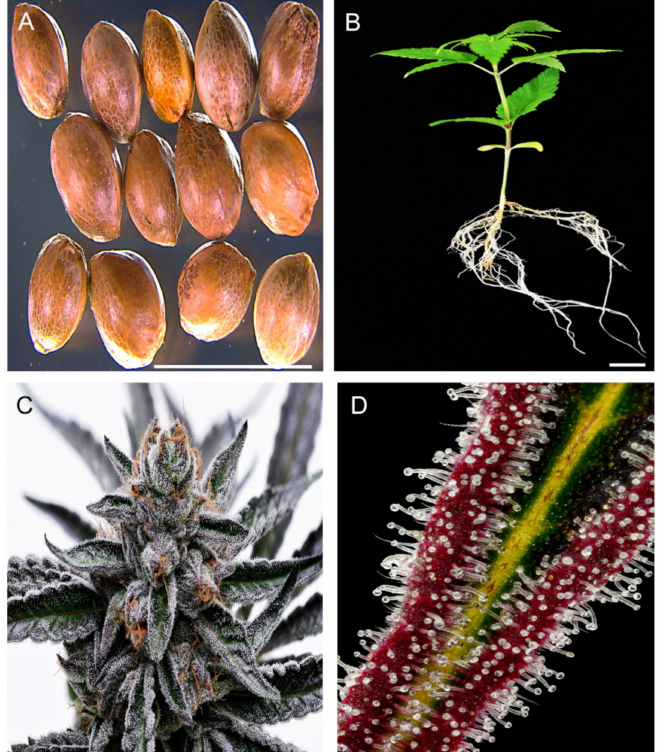
Figure 1. Cannabis sativa description. ( A ) Hemp seeds of the Korean cultivar, Cheungsam. ( B ) Two-week-old hemp seedling. ( C ) Cannabis inflorescence and upper leaves covered with tri- chomes. ( D ) Glandular trichomes of Cannabis. ( C , D ) by Curtis Taylor and used here with permission. (Scale bar: 1 cm)